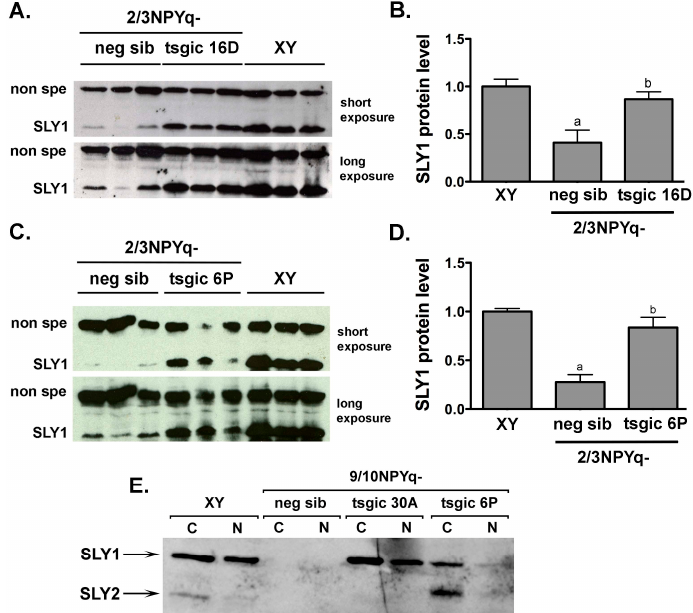
Figure 3. Addition of the Flag-Sly transgenes to males with NPYq deficiency rescues SLY1 and SLY2 expression deficiency . ( A – D ) Western blot was performed with whole testes lysates obtained from XY males and from males with moderate NPYq deficiency (2/3NPYq-) with (tsgic) and without (neg sib) Flag-Sly transgene addition. Two transgenic lines were tested: 16D positive for the Sly1 transgene ( A , B ) and 6P positive for both the Sly1 and Sly2 transgenes ( C , D ). Levels of protein expression shown in panels ( A , C ) were quantified with ImageJ software, normalized to a non-specific band ( B , D ) with XY data serving as the normal expression baseline. The normalization for line 6P was also done to Ponceau signal (Figure S7). The data represent an average ± SEM with n = 3. Statistical significance ( t -test, p < 0.05): a different from XY; b different from neg sib. ( E ) Western blot was performed with cytoplasmic (C) and nuclear (N) protein lysates from the whole testes obtained from XY males and males with severe NPYq deficiency (9/10NPYq-) with (tsgic) and without (neg sib) Sly transgene addition. Two transgenic lines were tested: 30A positive for the Flag-Sly1 transgene and 6P carrying both the Sly1 and Sly2 transgenes. Due to the scarcity of testicular material, the reference gene was not included in this